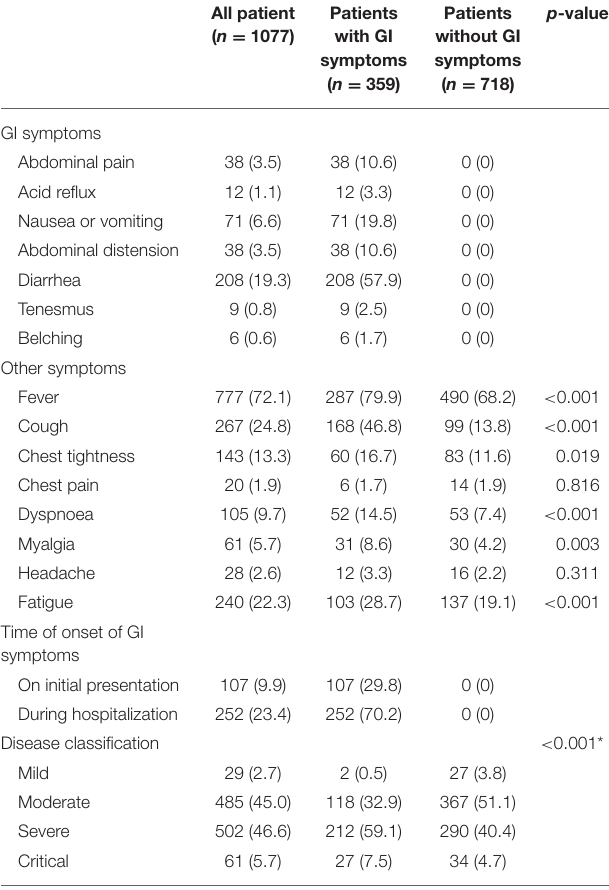
TABLE 2 | Clinical features, disease classification of patients with COVID-19 with and without GI symptoms. All patient ( n =